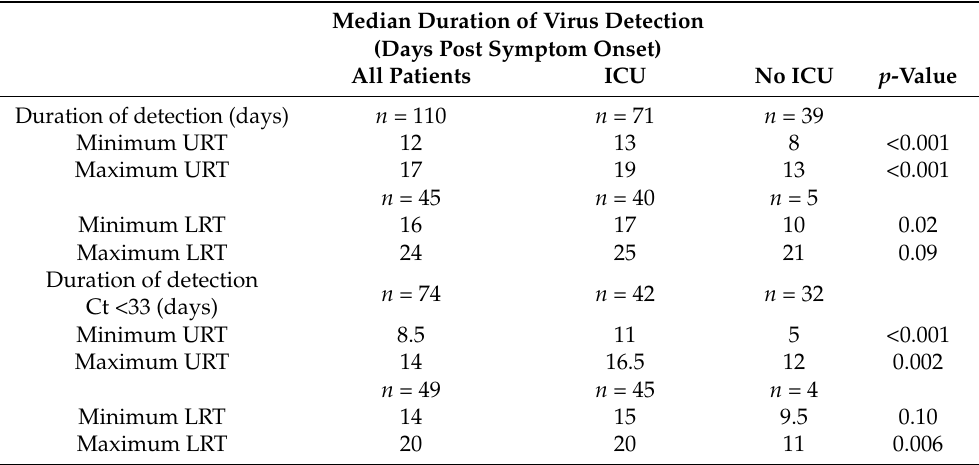
Table 1. Duration of virus detection since symptom